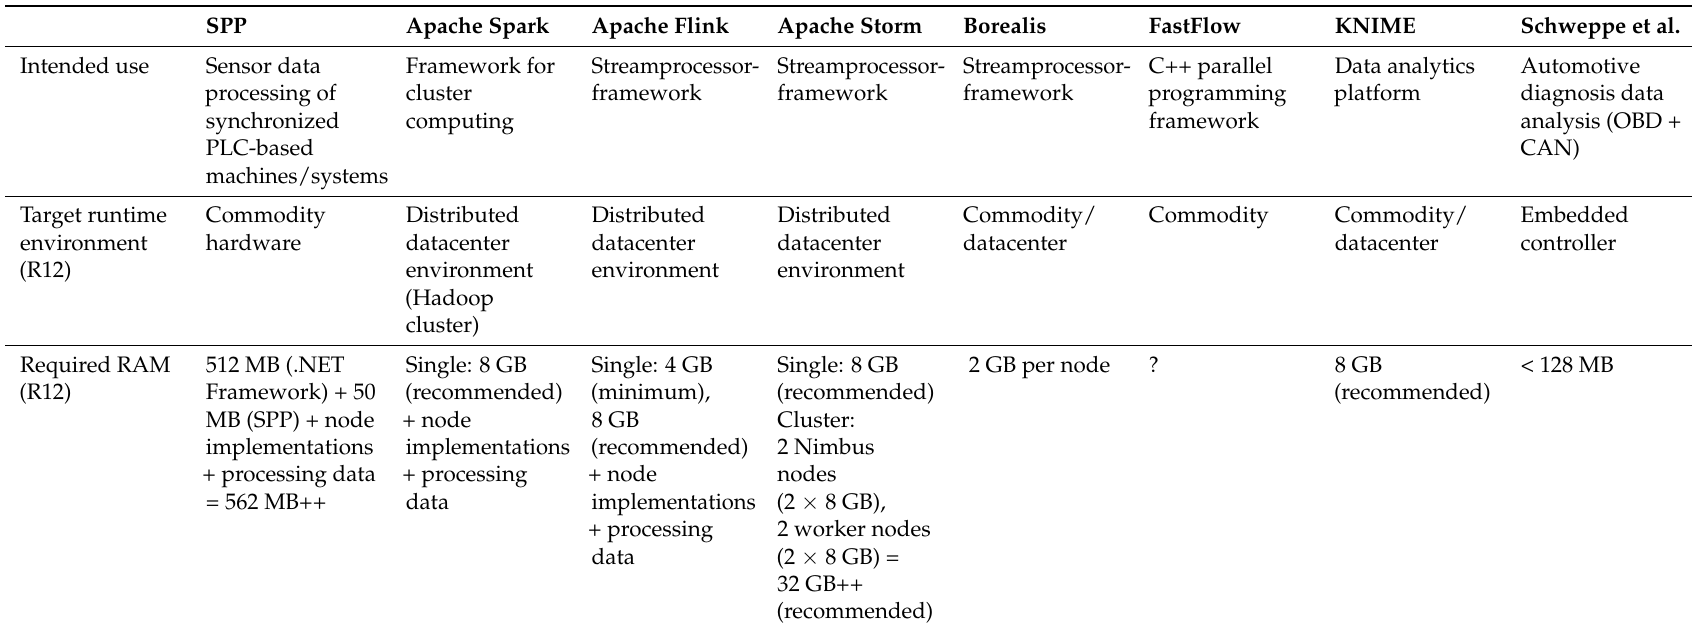
Table A1. General